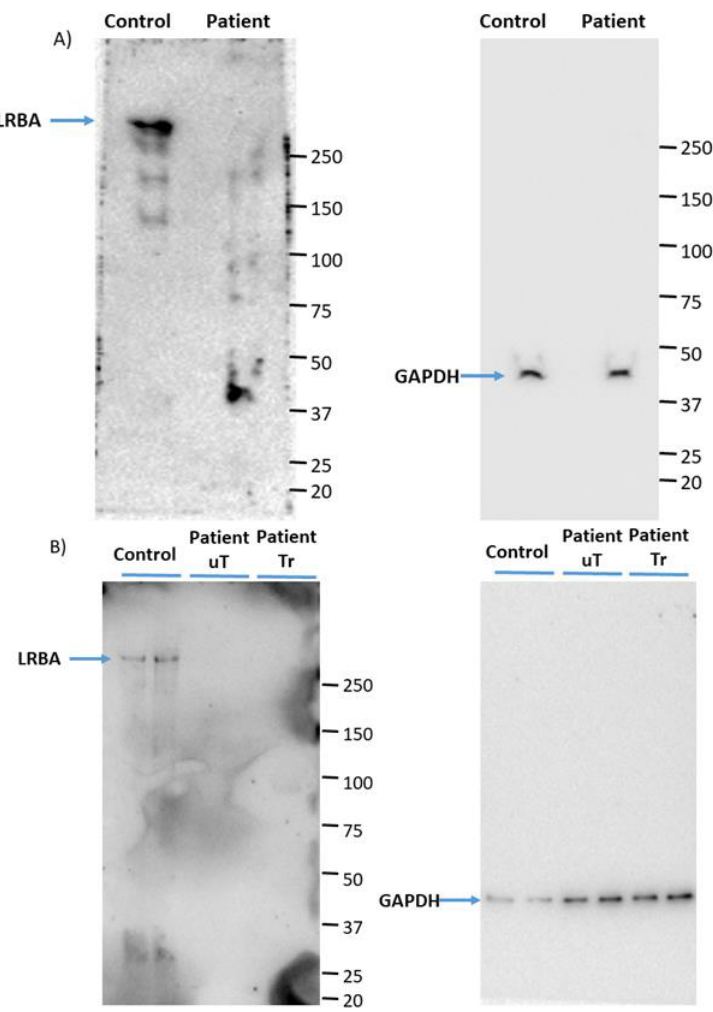
Figure 1. Western blots of patient PBMCs ( A ) freshly isolated from blood, and ( B ) 7 days after culturing the PBMCs in RPMI. uT (untreated) designates PBMCs isolated from blood taken before the patient was treated with Abatacept while Tr (treated) designates PBMC isolated from blood taken after the patient was treated with Abatacept. GAPDH was used as a loading